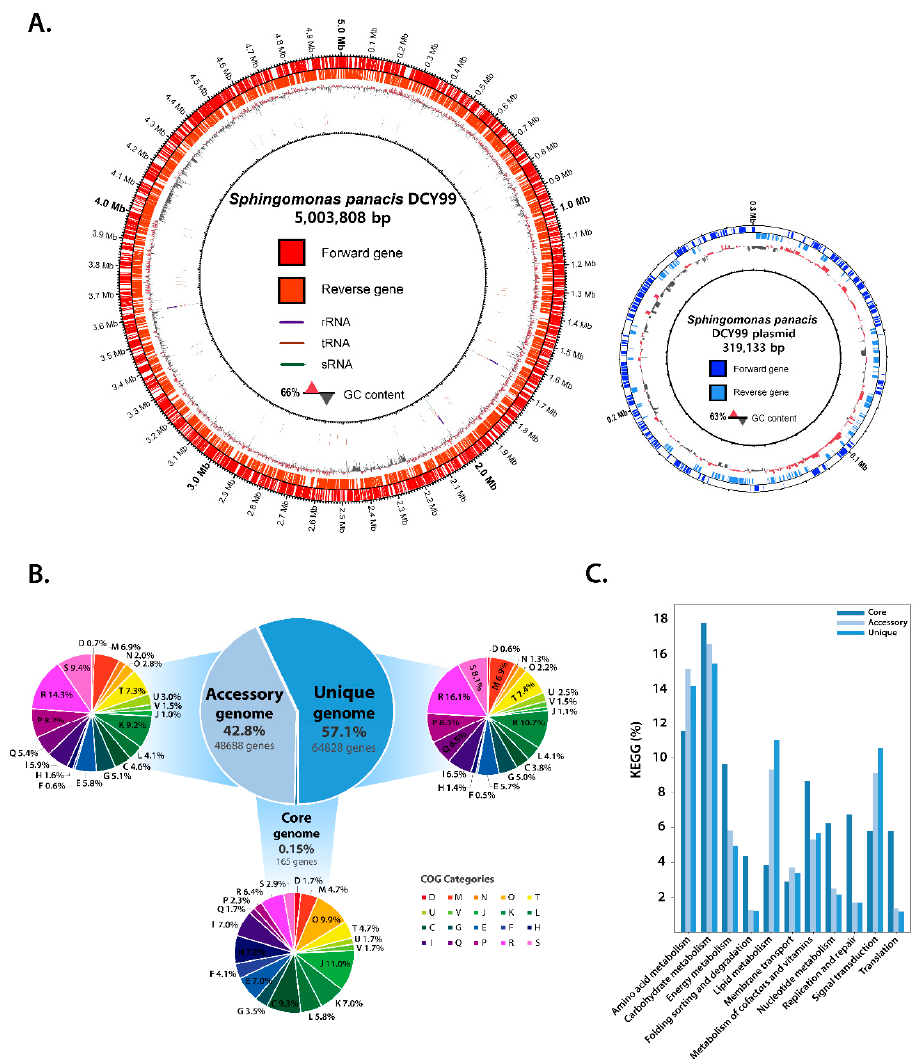
Figure 1. ( A ) Visualization of the circular genome of S. panacis DCY99 T . The genome is shown with a base pair (bp) ruler on the outer ring. The S. panacis DCY99 T main chromosome is 5,003,808 bp in size; the plasmid is 319,133 bp in size. The chromosome is arranged clockwise. The two outer circles represent S. panacis DCY99 T CDSs on the forward and reverse strands, respectively. The next circle indicates GC% content and next three circles indicate rRNA, tRNA, and sRNA, respectively. The S. panacis DCY99 T plasmid does not contain the three RNAs. ( B ) Sphingomonas pan-genome statistics.